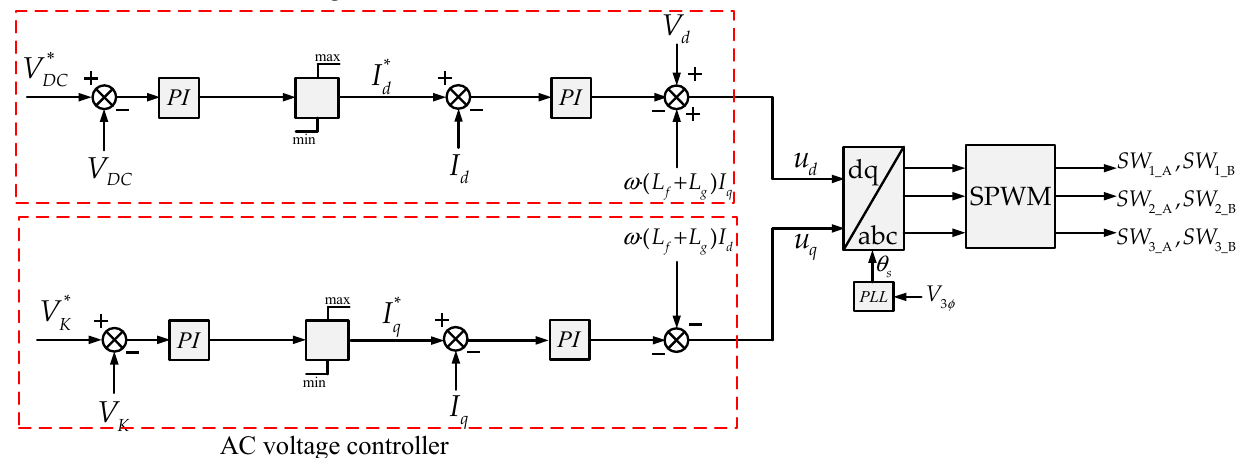
Figure 4. GVSC Controller.